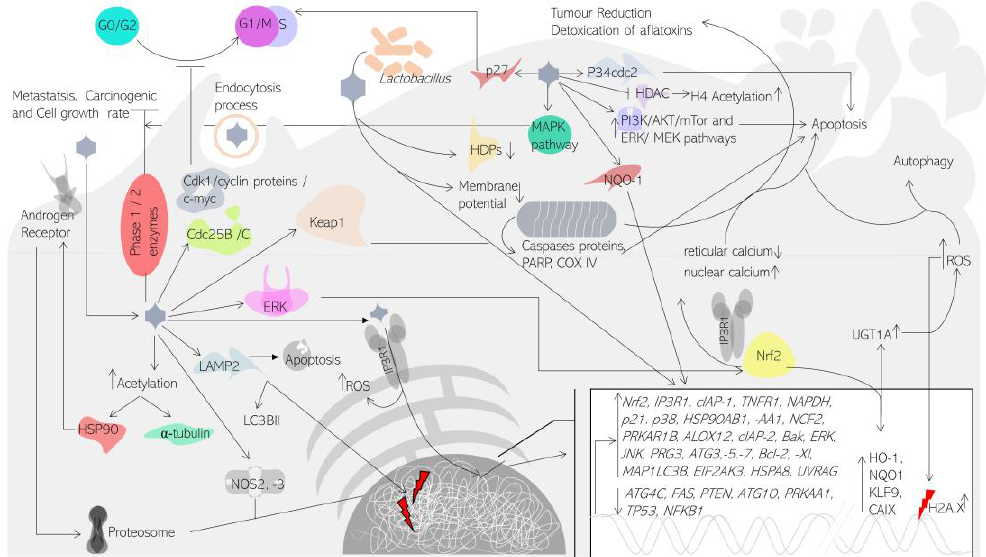
Figure 1. Molecular pathways related to sulforaphane treatment. Molecular targets of sulforaphane could improve the response of actual cancer treatments and triggered autophagy, apoptosis, DNA damage, and/or cell cycle arrest.